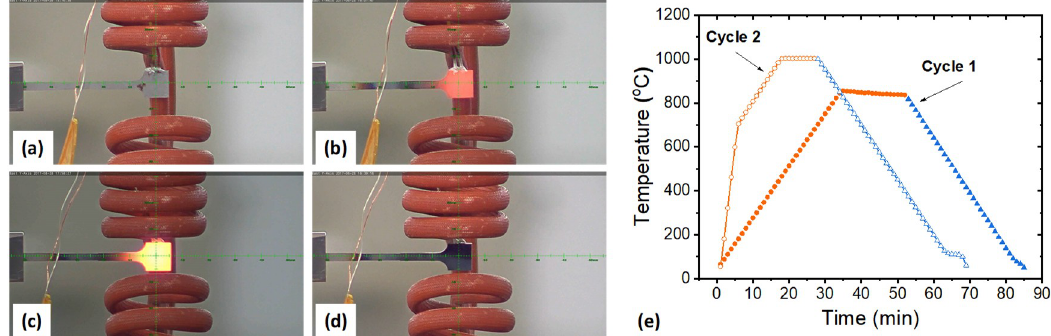
Figure 1. Schematic configuration of the real‐time in situ neutron diffraction on the sample under heating by induction coils. The upper right inset shows the camera view of the heating set‐up.